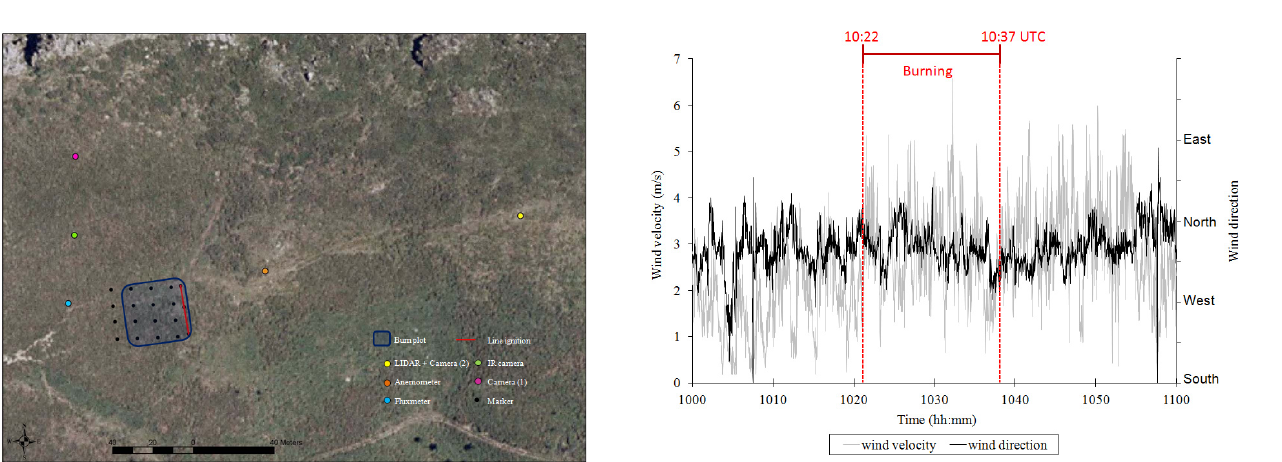
Fig. 1. Experimental site and array of devices.